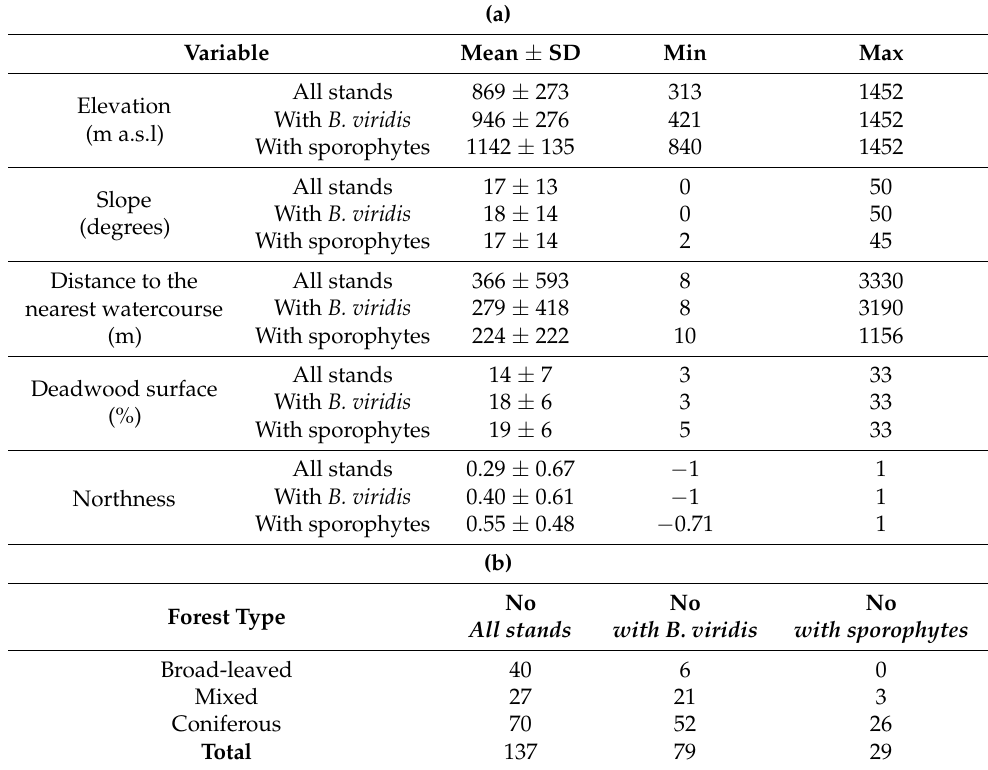
Table 1. Description of the set of environmental quantitative variables (a) and qualitative variable (b) of all stands surveyed (137), stands containing Buxbaumia viridis (sporophyte + sterile protonema) (79) and stands containing sporophytes (29). No: